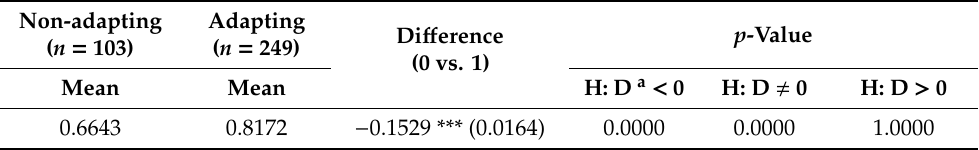
Table 5. Di ff erence test of means in technical e ffi ciency by adaptation response. Non-adapting